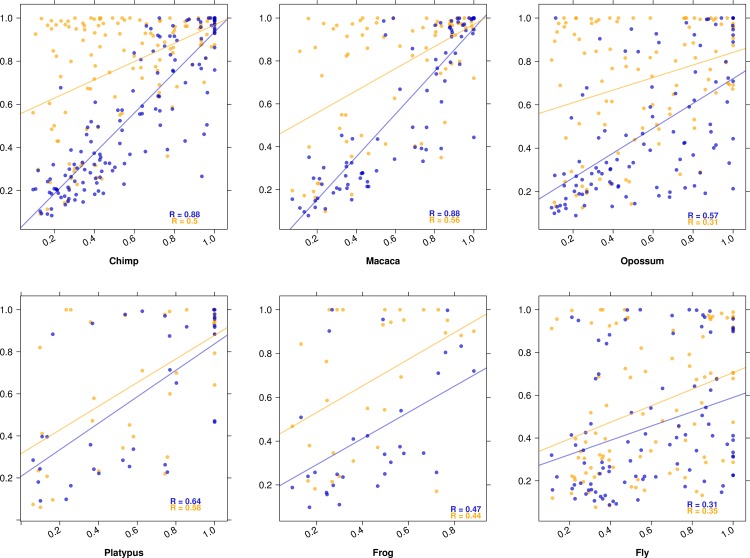
Distribution of tissue-specificity in paralogs compared to an outgroup ortholog.For each graph, paralogs of a given phylogenetic age are compared to the closest outgroup un-duplicated ortholog; thus these paralogs are "in-paralogs" relative to the speciation node, and are both "co-orthologs" to the outgroup. X-axis, τ of unduplicated ortholog. Y-axis, τ of paralogs. Blue points are values for the paralog with highest maximal expression of the pair of paralogs, orange points are values for the other.